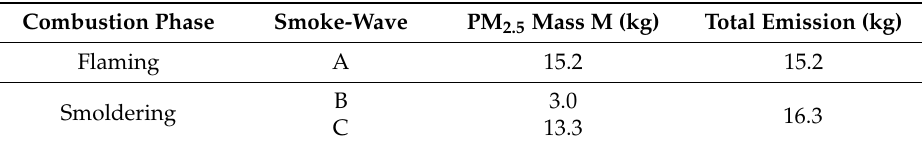
Table A5. Total PM 2.5 Emission from flaming and